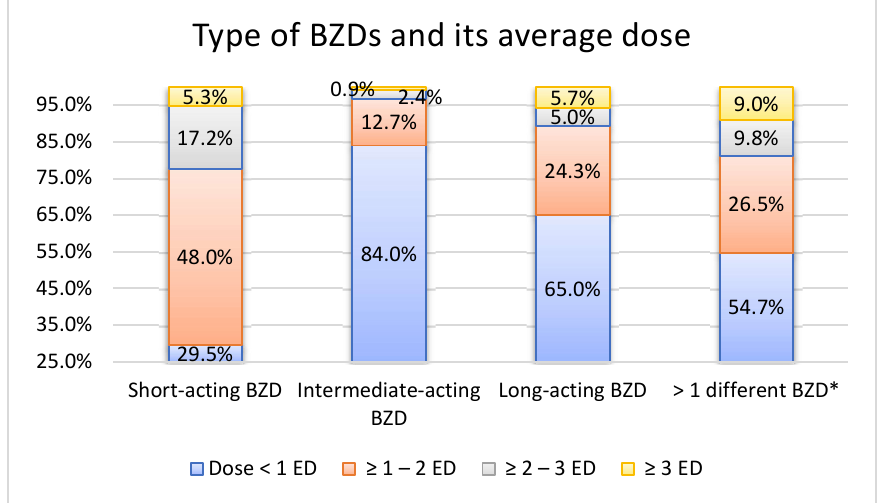
Figure 2. Average dose depending on type of benzodiazepine (BZD). * A significant number of patients had used different types of BZDs during the surveyed time period.